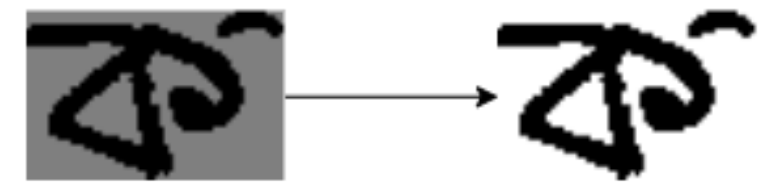
Figure 6. Example of binarization on a sample image.